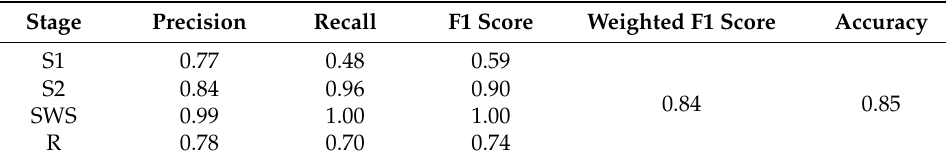
Table 2. Experiment results for test data (Exp1).